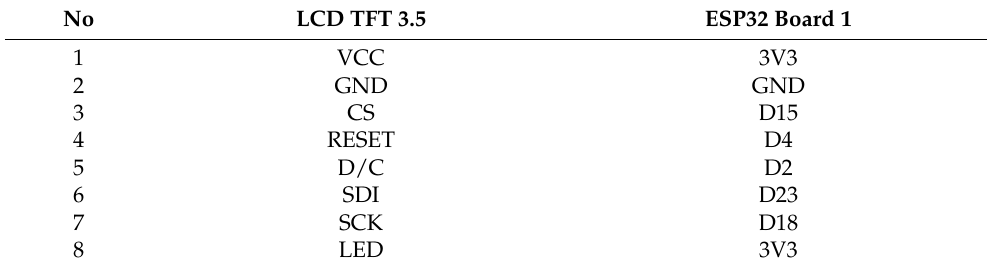
Table 1. Communication between LCD and ESP32 Board 1.